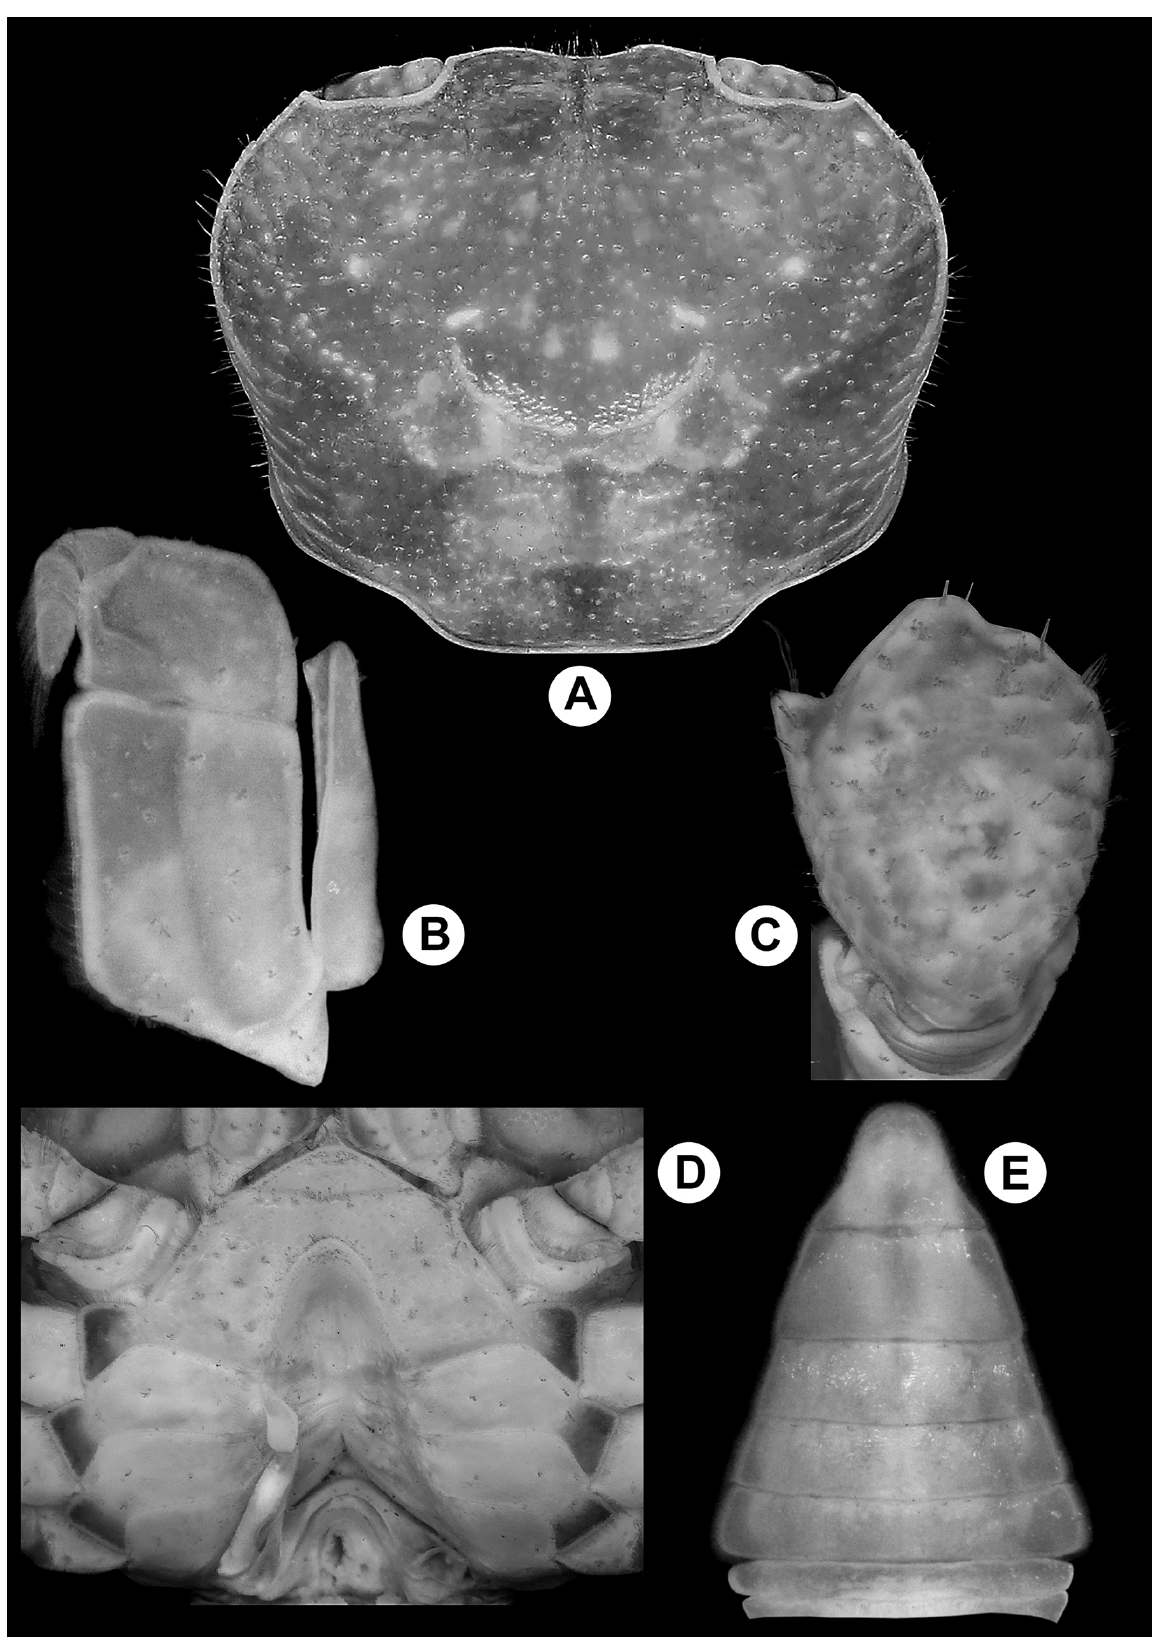
Figure 2. Abormon praecalvum sp. nov., holotype male (12.9 × 10.5 mm) (ZSI-WRC C.1941). A , dorsal view of carapace; B , left third maxilliped; C , carpus of right cheliped; D , thoracic sternites with G1 in situ (left G1 removed); E , pleon and